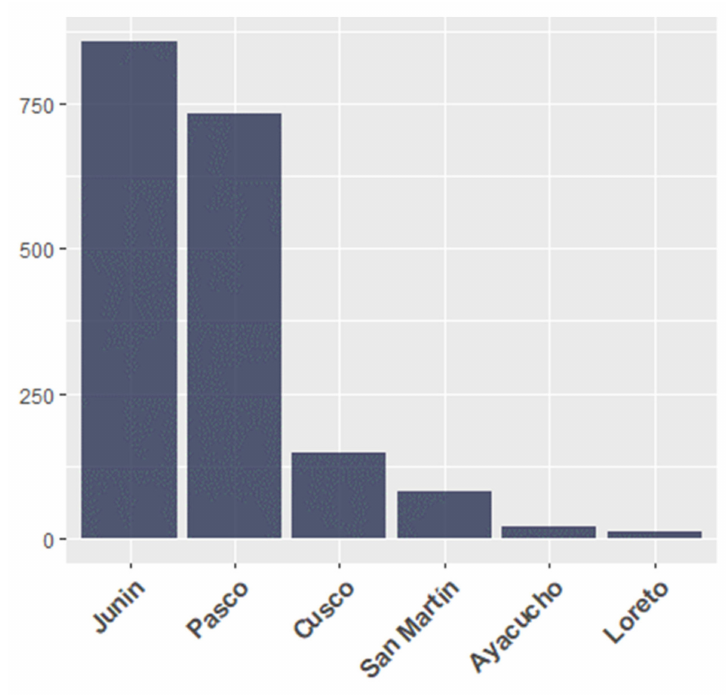
Figure 3. Number of observations of vigilance committees, per region. The graph in Figure 4 represents the number of satellite-based alerts and CBMs by region (Figure 4 Number of observations per region, divided into CBM and satellite-based alerts). Other graphs show the number of field observations according to type: Mobile-alert- driven monitoring; paper-based alert-driven monitoring, and routine monitoring. Overall, only eight communities had satellite-based alerts as well as alert-driven monitoring in the dataset. Communities Puerto Ocopa, Loma Linda, and San Pedro de Pichanaz all used mobile devices instead of paper- based field reports. Furthermore, alert-driven monitoring observations explicitly referred to satellite-based alerts.